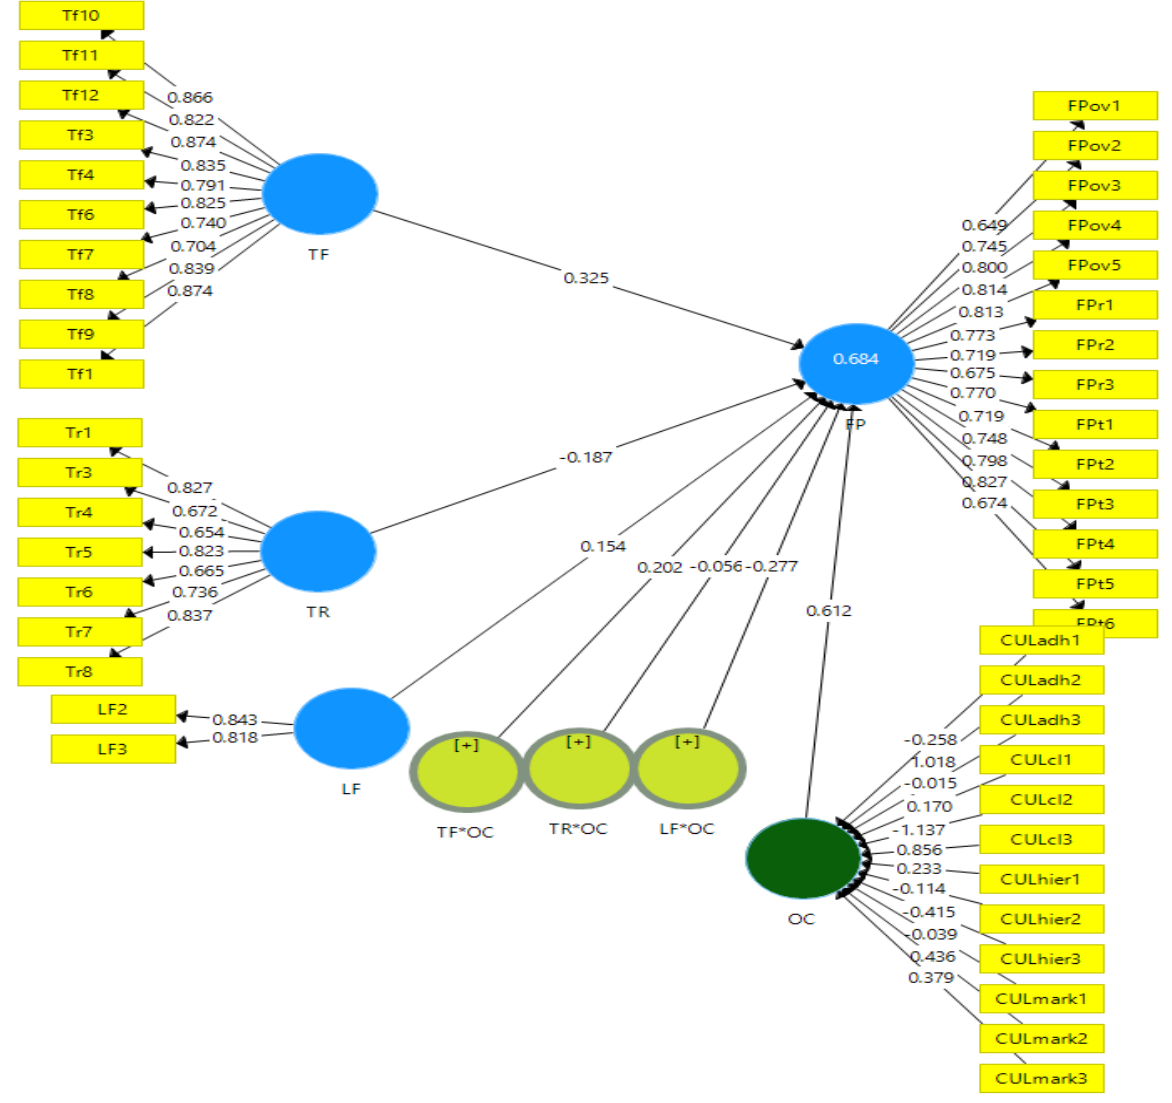
Fig. 5. Interaction Effect